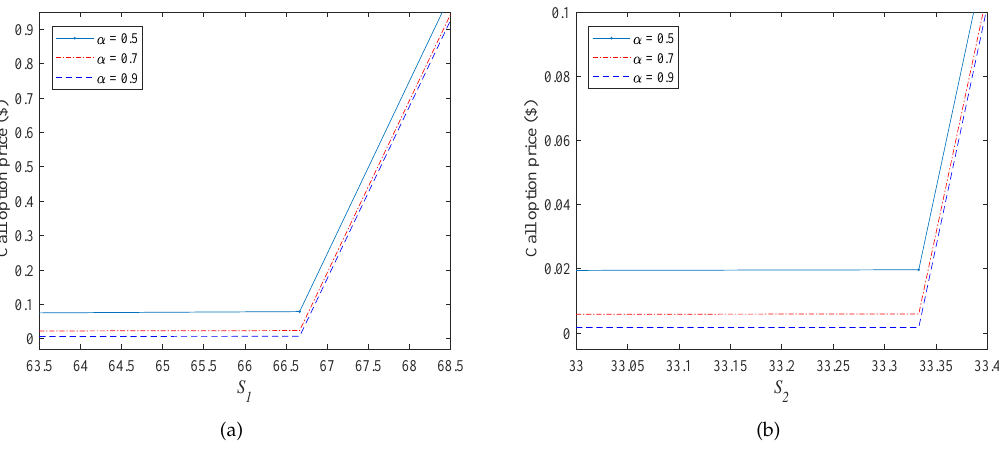
Figure 4. Solution plots of European call option obtained from the model with different orders α = 0.5,0.7,0.9 at a day before an expiration date: ( a ) S 2 = 5; ( b ) S 1 = 10.